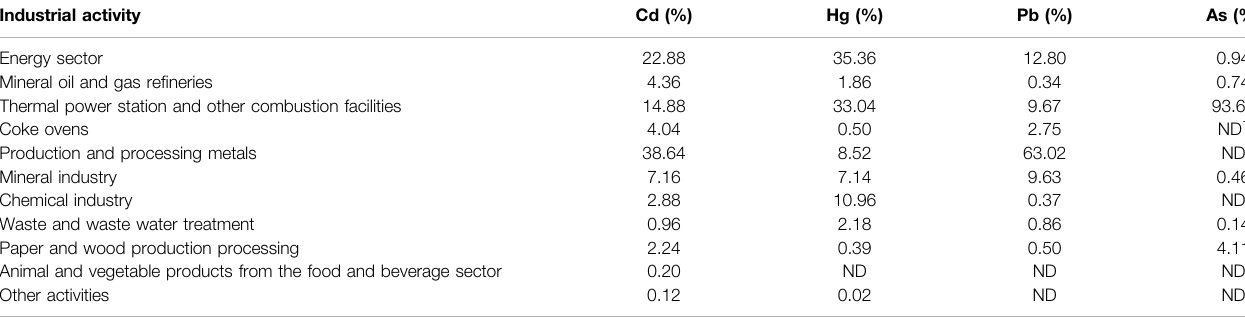
TABLE 1 | HM emission from different sources into the air (Simeonov et al., 2011; Shahid et al., 2017b). Industrial